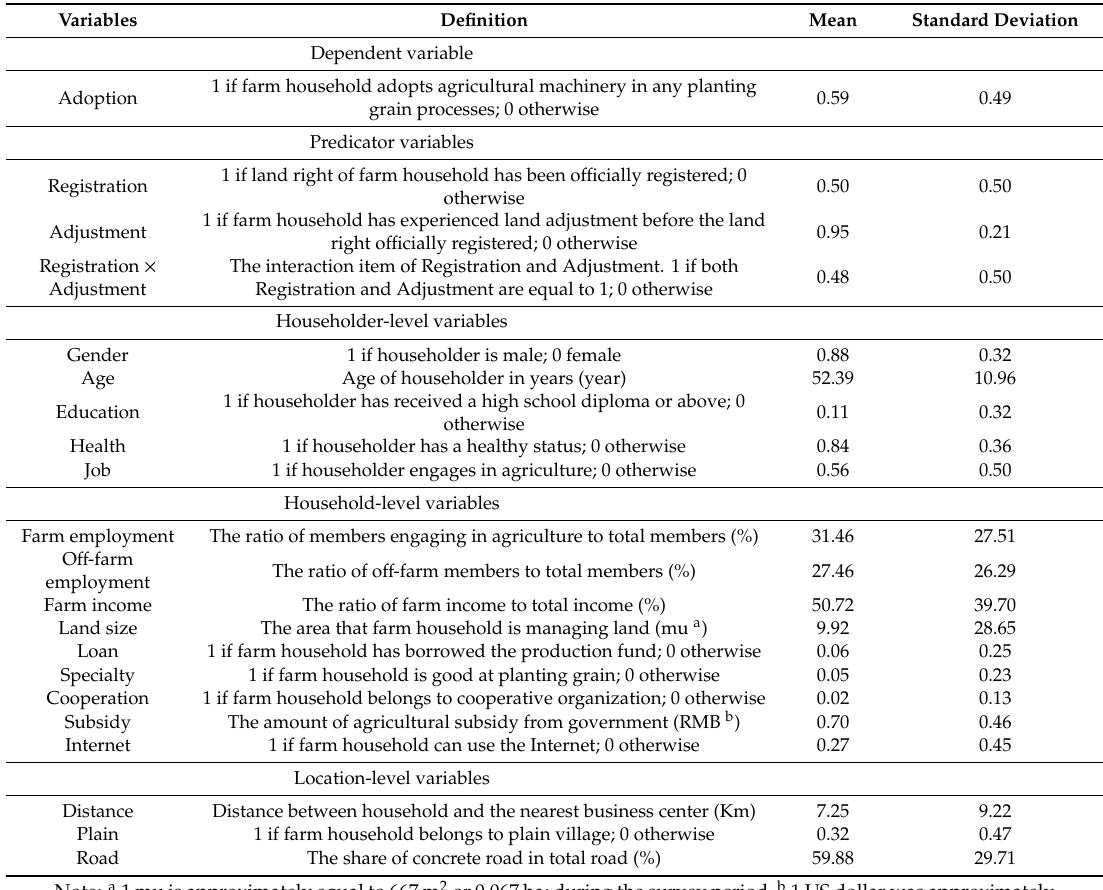
Table 1. The definition and data description of the variables in the